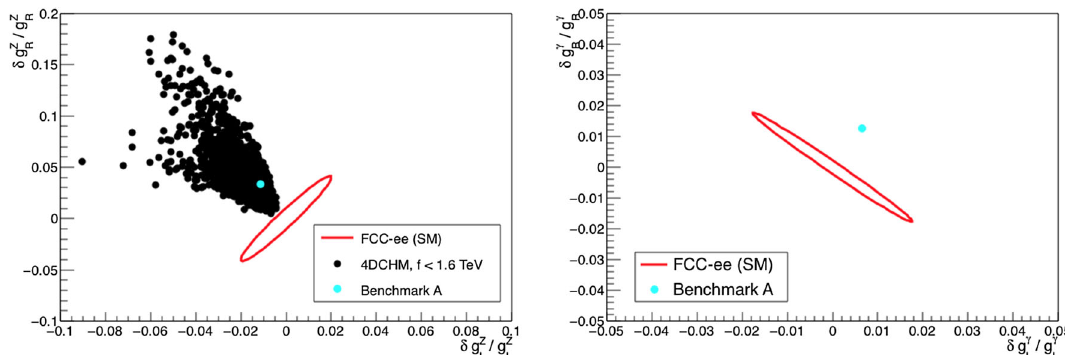
deviations from various composite Higgs model for f ≤ 1 . 6TeV. The